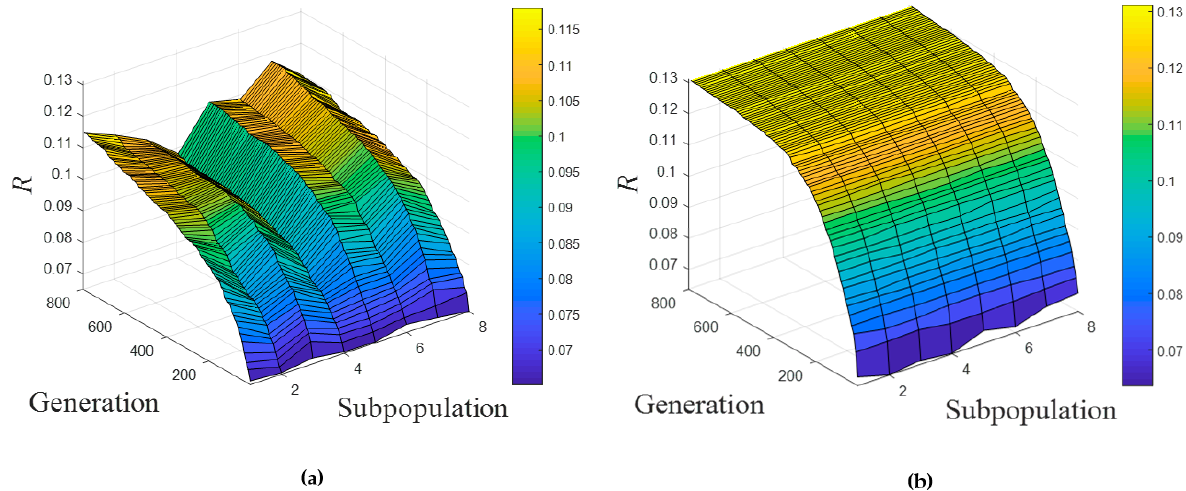
Figure 8. The comparison between the conventional genetic algorithm (GA) and MPEA-RSN. ( a ) The conventional GA. ( b ) MPEA-RSN.